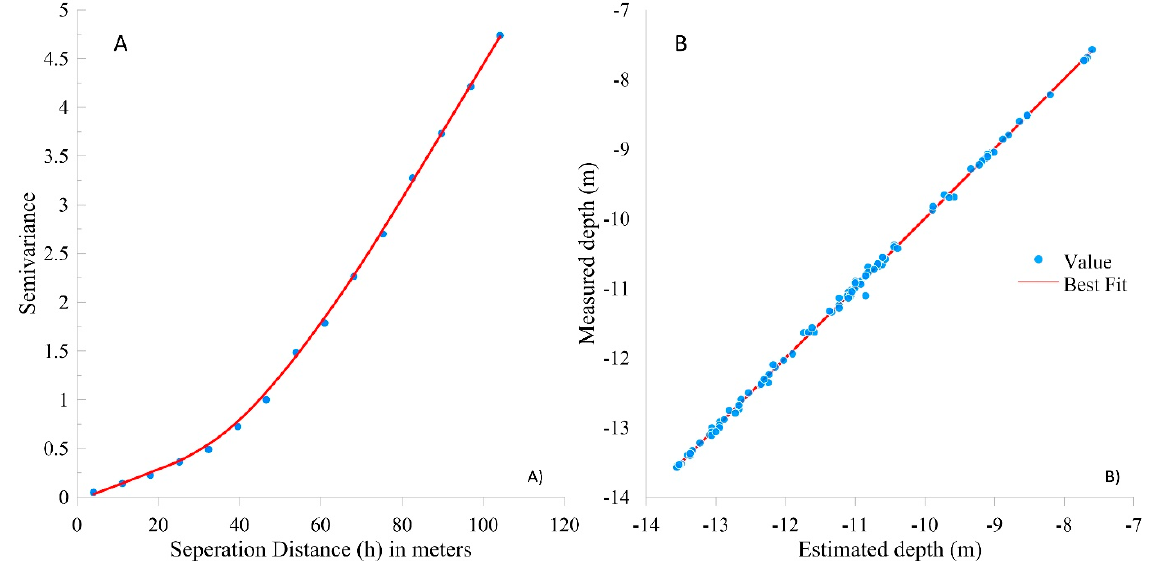
Figure 4. ( A ) Semi-variogram model showing the Gaussian best fit line with the very low residual sum of squares (0.0021) typically used for validation. ( B ) Cross-validation post kriging showing the linear fit between measured values and estimated values with the best fit at almost 1:1.